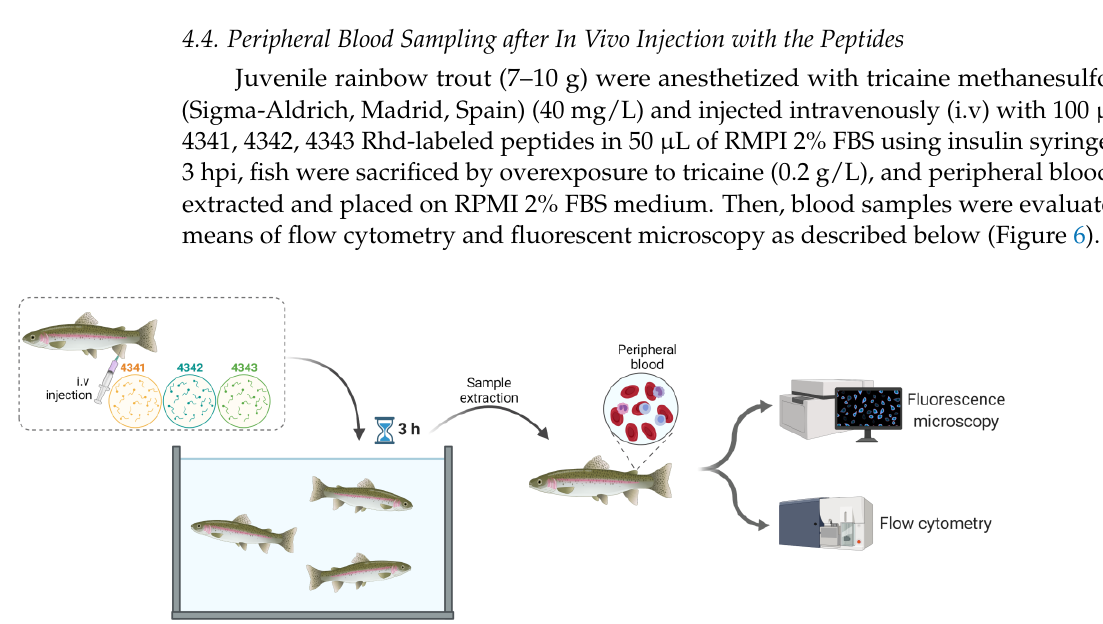
Figure 6. Workflow of in vivo evaluation of peptide binding to rainbow trout RBCs. Created with BioRender.com (accessed on 21 October